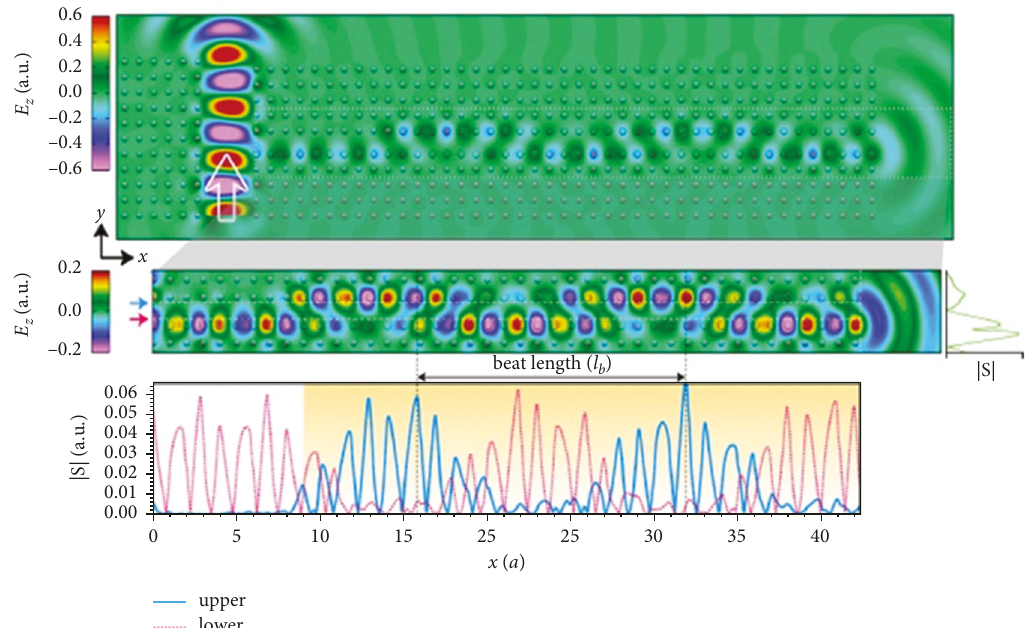
Figure 5: (Color online) FDTD simulation of surface mode coupling at ω transition and coupling regions, whereas the bottom panel presents the variation of Poynting vector magnitude along the horizontal dash- dotted cutlines. The plot to right on the middle panel depicts the variation of hollow arrow in the top panel indicates the initially launched wave direction, whereas the shaded area in the bottom panel denotes the coupling region.